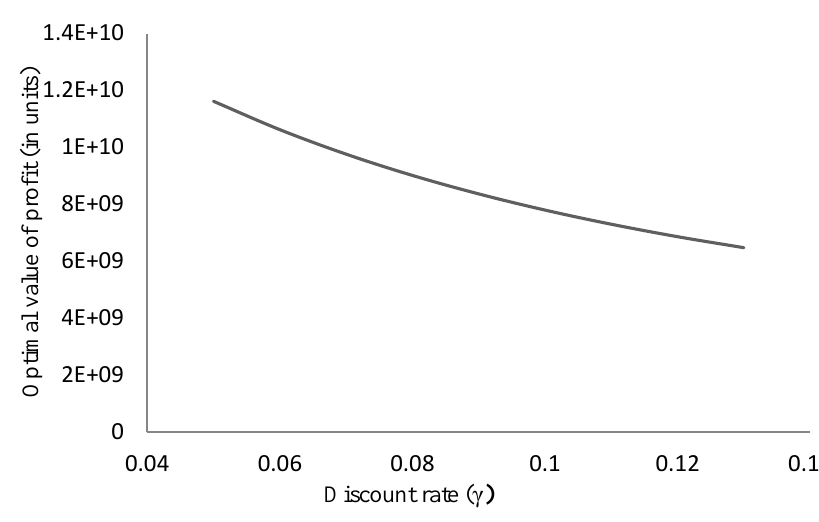
Figure 3. Optimal value of profit with different discount